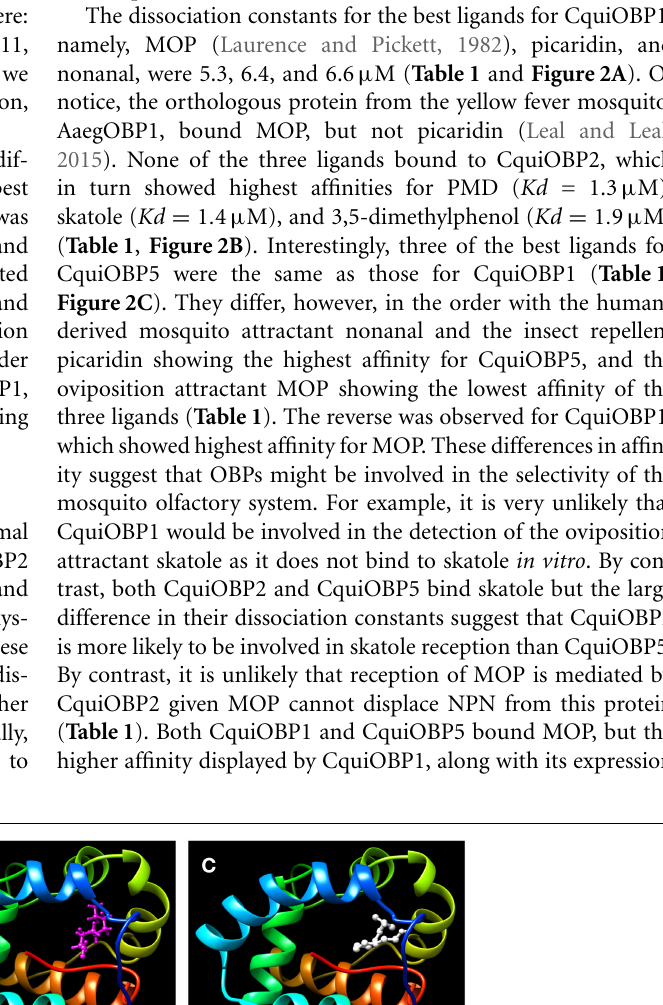
cavity and a large part of the hydrophobic chain is bound in the hydrophobic tunnel formed between helices 4 and 5. (E) Close up view of (D) Note that a segment of MOP about 5-carbon longer than the other ligands sticks inside the hydrophobic tunnel. CquiOBP1 is displayed in Chimera with rainbow-colored scheme from N-terminus in blue to C-terminus in